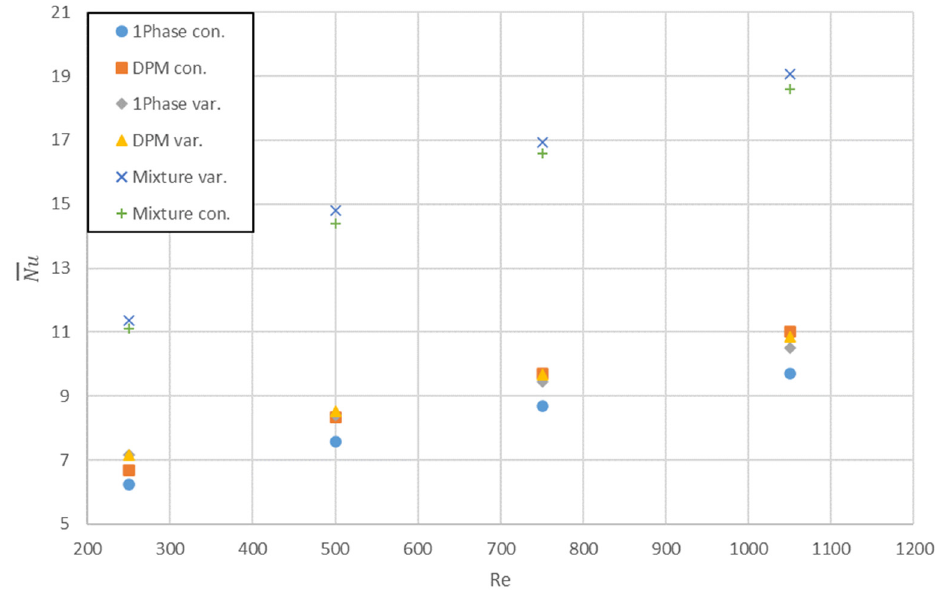
Figure 5. 𝑁𝑢(cid:3364)(cid:3364)(cid:3364)(cid:3364) ‐ Re relationship for water–Al 2 O 3 (4%) nanofluid—data source [51]. Rashidi et al. [52] used single ‐ phase model, VOF model, mixture model, and